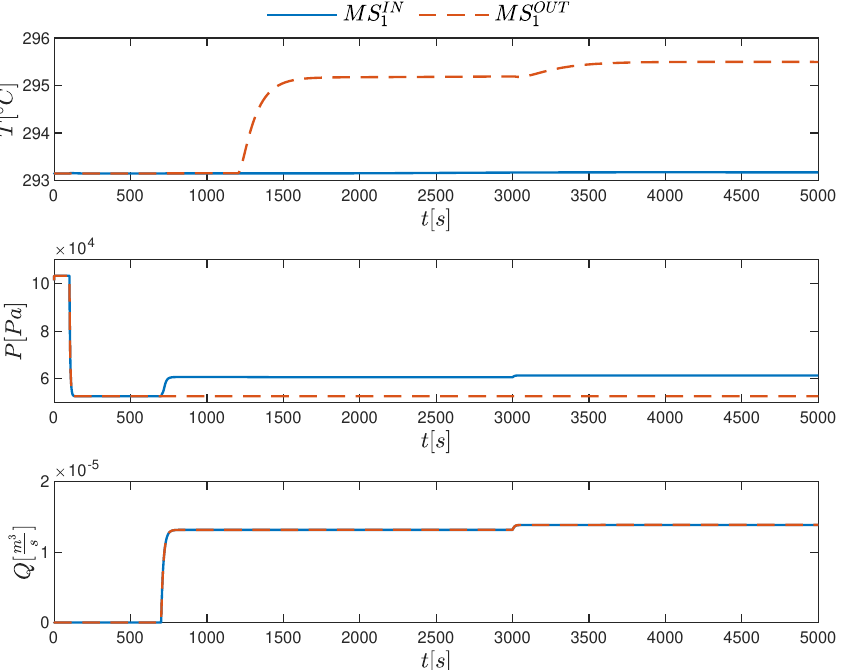
Figure 21. Temperature, pressure and volumetric flow change in the system during the simulation scenario. Measurements have been taken before the first section ( MS IN ( MS OUT 1